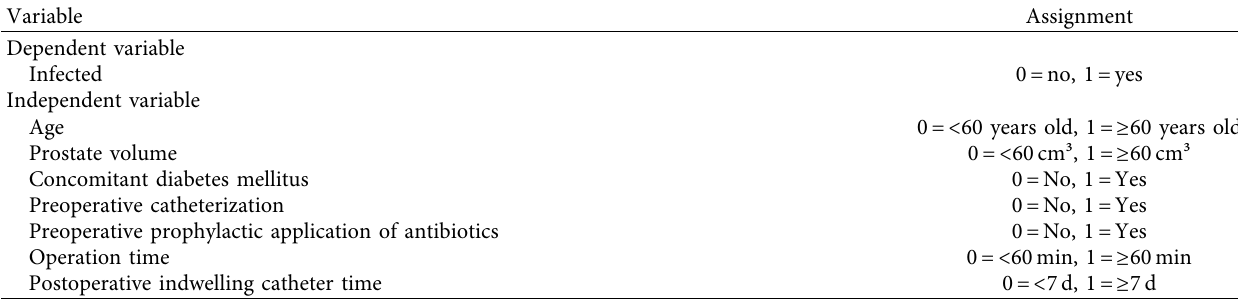
Table 2: Variable assignment of risk factors affecting postoperative urinary pathogenic bacteria infection in BPH patients. Variable